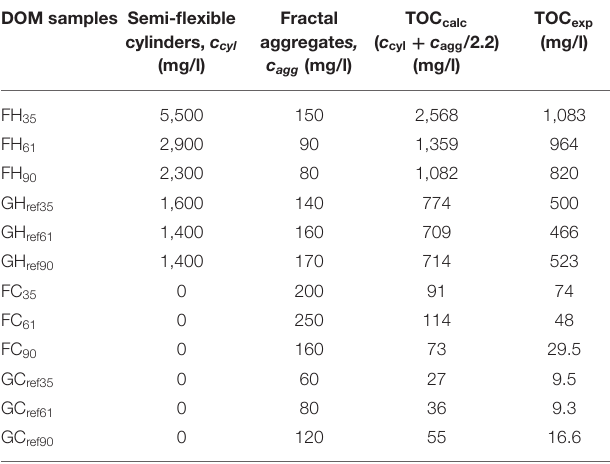
TABLE 4 | Summary of the SAXS modeling results of all DOM samples. DOM samples Semi-flexible cylinders, c